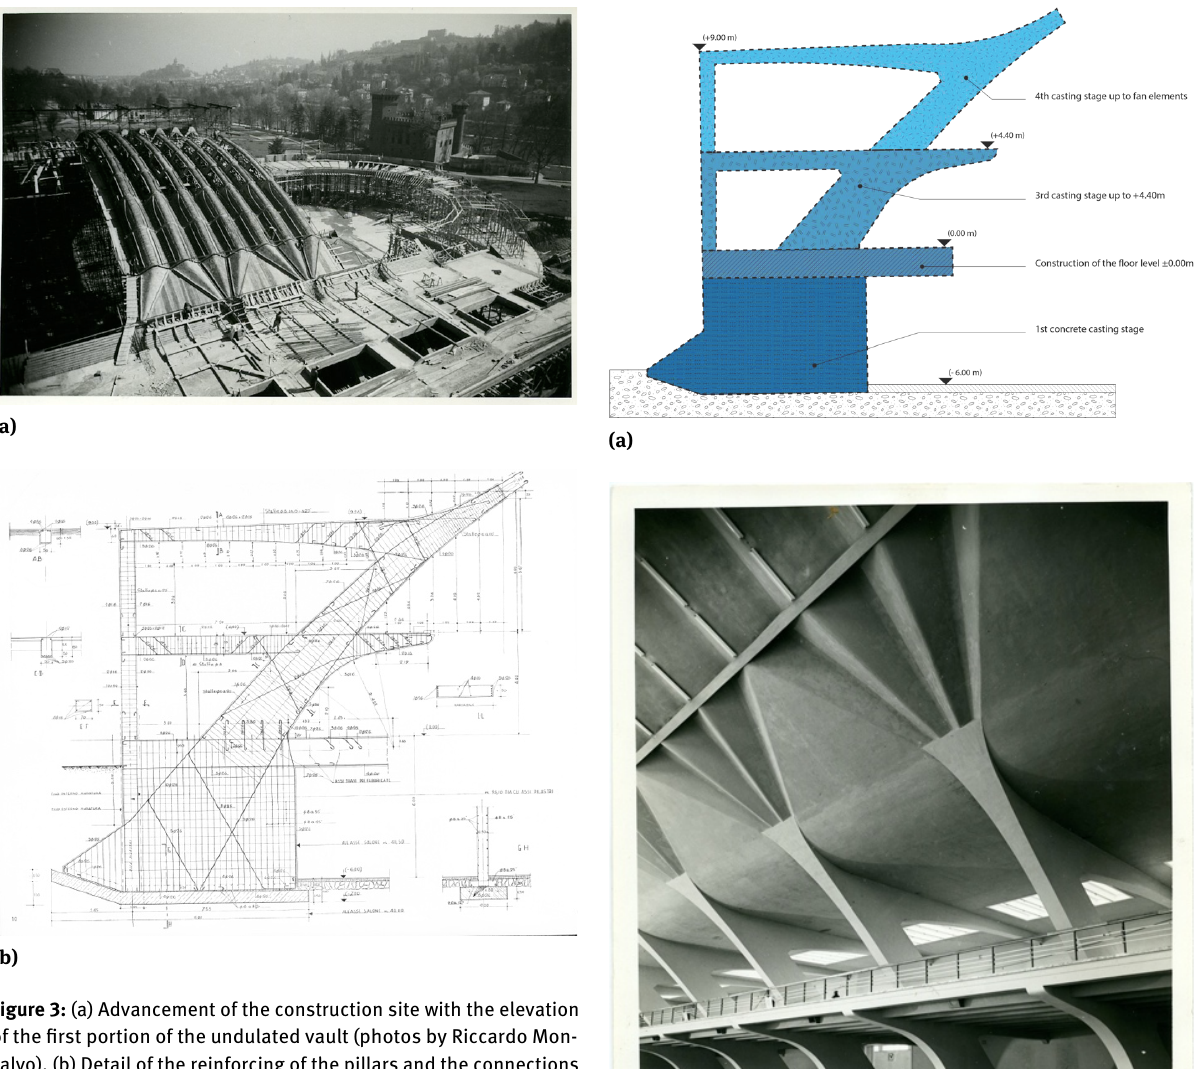
ingly. In Figure 2b, a red arrow indicates a pillar that has not been cast, while the ones closer to the apse are in